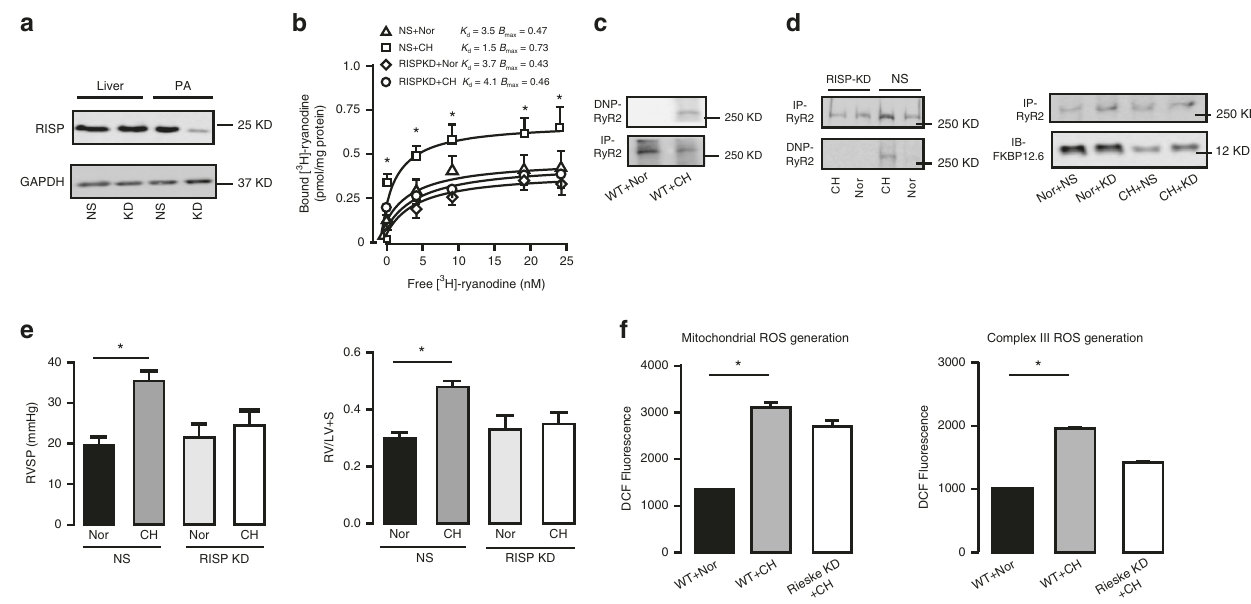
Fig. 6 Silencing RISP mitigates the hyperfunctional RyR2 activity after CH. a Representative western blot of in vivo speci fi c silencing RISP in PAs rather than liver using shRNA-mediated lentivirus hydrodynamic intravascular (jugular vein) delivery technique. (NS, shRNA of non-silencing; KD, knock down group). b RyR activity in RISP KD group is measured by [ 3 H]-ryanodine binding assays ( n = 5 independent studies, 5 mice per study). c Representative western blot of oxidized RyR2 from PAs after exposure to CH in the same fi lm. The oxidation levels are assayed using an anti-2,4-dinitrophenyl (DNP) antibody against ROS-mediated, DNP-derivatized protein carbonyls. d RISP KD suppresses the oxidation of RyR2 and reverses remodeling of FKBP12.6/ RyR2 complex determined by western blot. e Silencing RISP in vivo prevents the development of CH-induced PH by measuring RVSP and RV/LV + S ( n = 5 independent studies, 5 mice per study). f Silencing RISP inhibits the mitochondrial-mediated and complex III-mediated reactive oxygen species (ROS) generation respectively. Data are expressed as mean ± standard error. (* P < 0.05, using one-way ANOVA